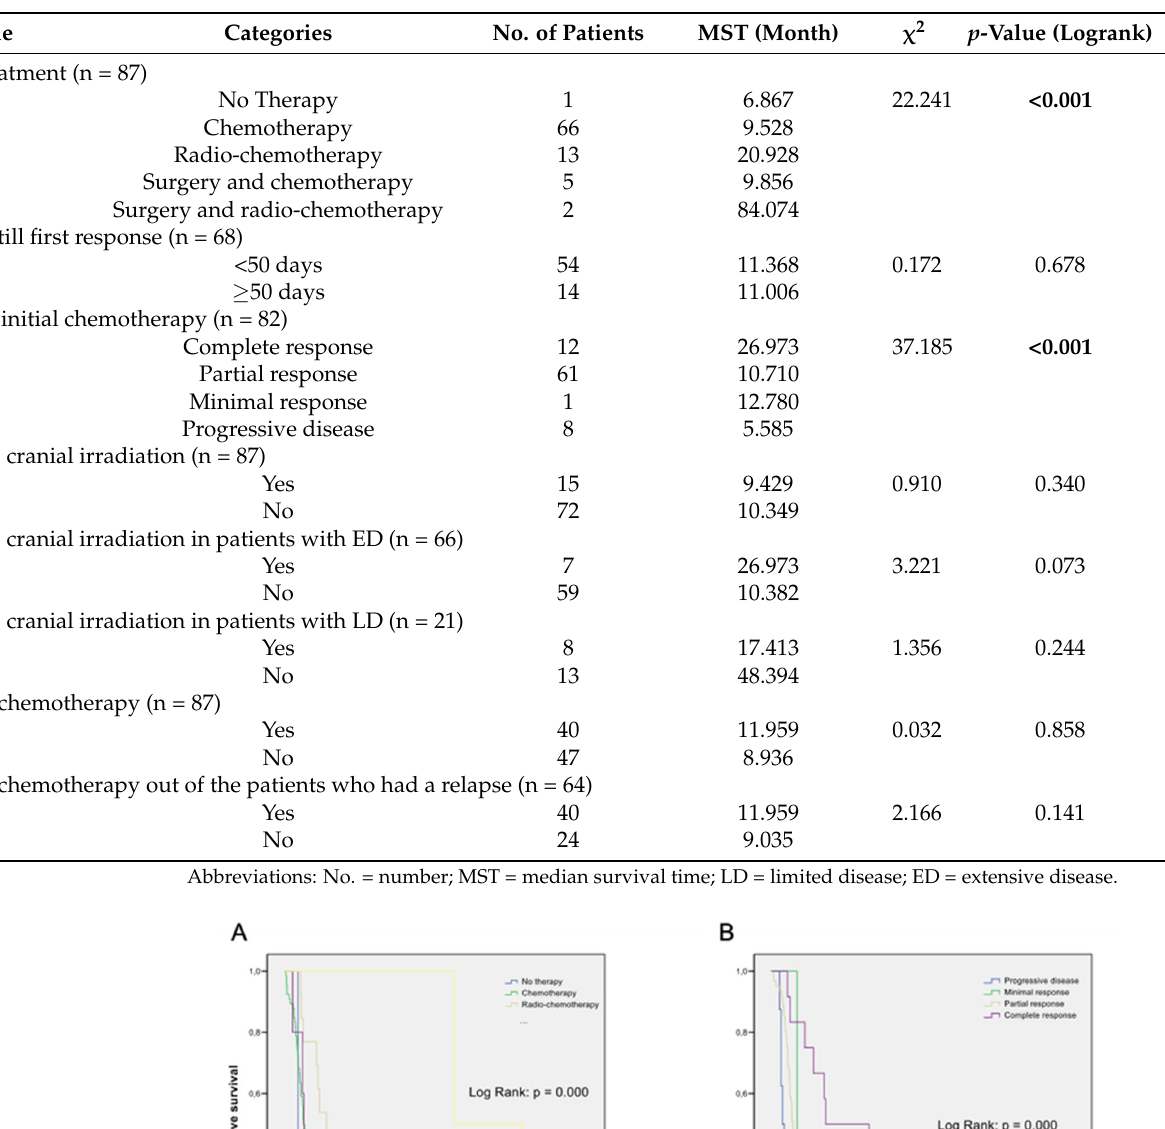
Figure 4. Kaplan–Meier graph for overall survival according to mGPS. N = 84; 0: n = 22; 1: n = 29; 2: n = 33. Table 4. Univariate analysis of staging systems . Prognostic Index with Categories